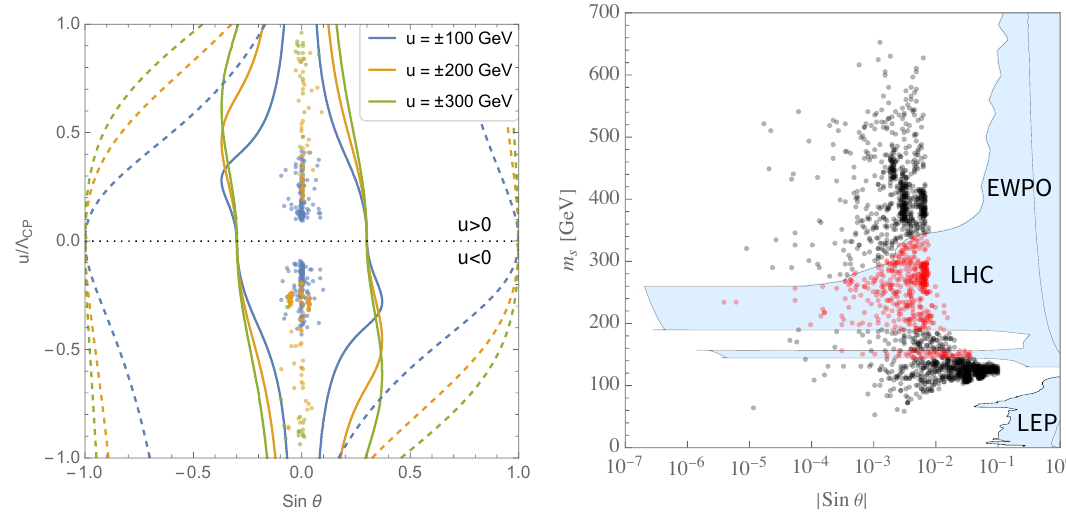
Figure 8 . Left: 2- σ allowed regions in the (sin θ, u/ Λ CP ) plane for different values of the singlet vev u , from a χ 2 fit to the Higgs signal strength measurements from ATLAS in its 10 th -year Higgs Legacy paper [159] (solid lines), and from a measurement of the CP structure of the h ¯ tt coupling by CMS [161] (dashed lines). Right: the (sin θ, m s ) plane showing regions excluded at the 2- σ level by LEP searches for light singlet-like scalars, LHC searches, and measurements of EW precision observables. The points selected for our baryogenesis analysis in section 7.5 are shown in black on the right panel (the red points are excluded by LHC searches), and in colours corresponding to the indicated values of u ± 5% in the left